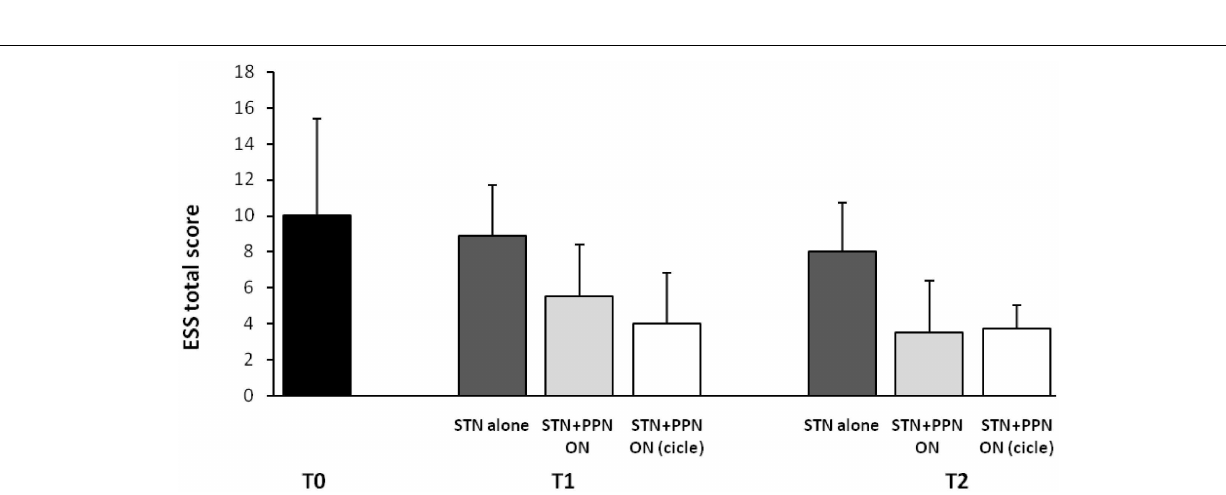
FIGURE 2 | Shown are mean results of Epworth sleepiness scale (ESS) in original PD patients implanted a long-time ago (2006–2007) in both STN and PPTg . Histograms refer to before surgery (T0), then 3 (T1), and